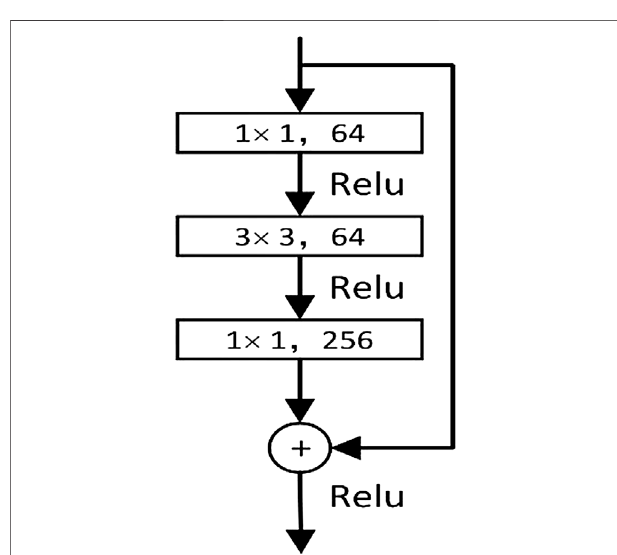
FIGURE 3 | Residual network structure.